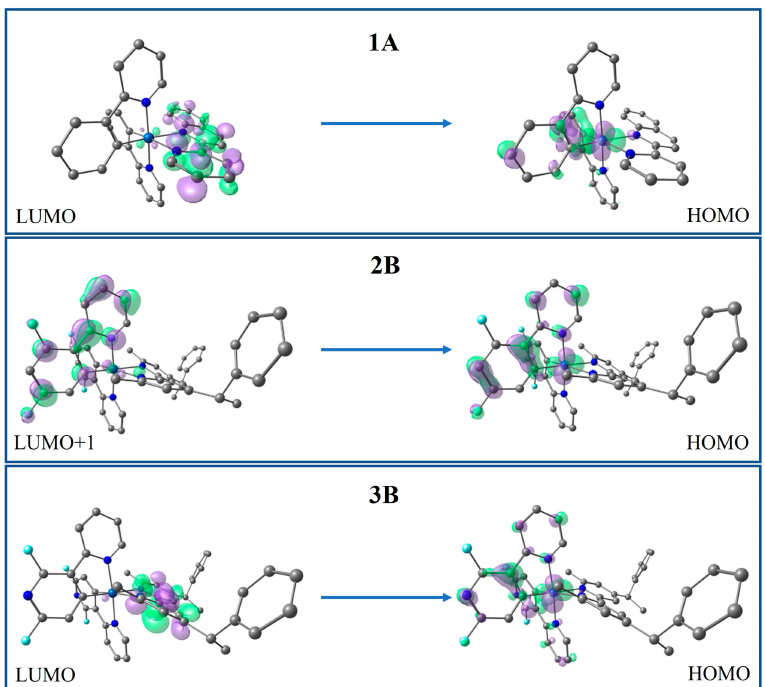
Figure 3. Radiative deactivation pathway of the triplet excited state of 1A , 2B and 3B , as representative of each series (for the rest of the complexes, see Figures